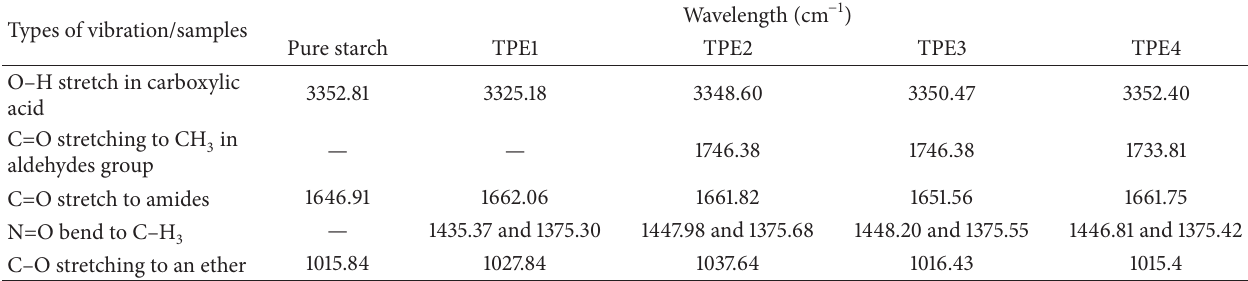
Table 2: Summaries of functional group in pure starch and starch incorporated with glycerol (TPE1), olein oil (TPE2), and crude palm oil (TPE3) and without plasticizer